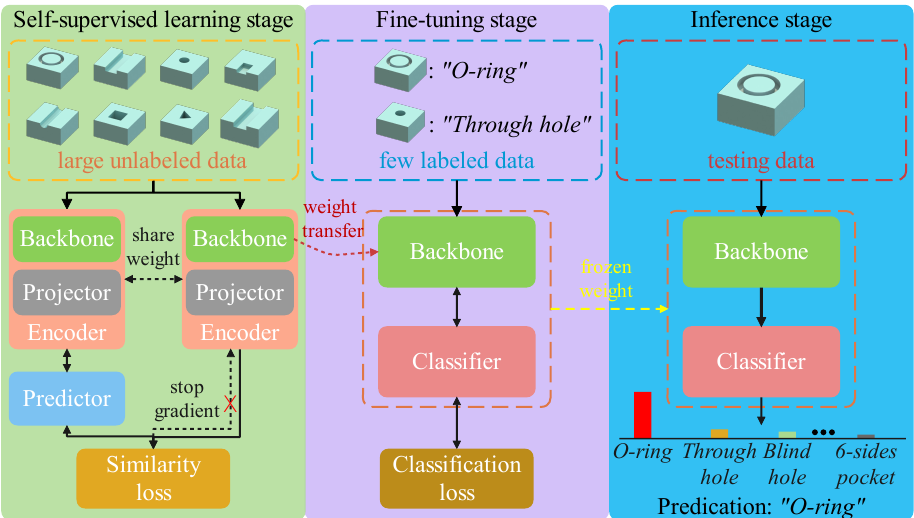
Figure 1. The pipeline of the proposed semi-supervised machining feature recognition